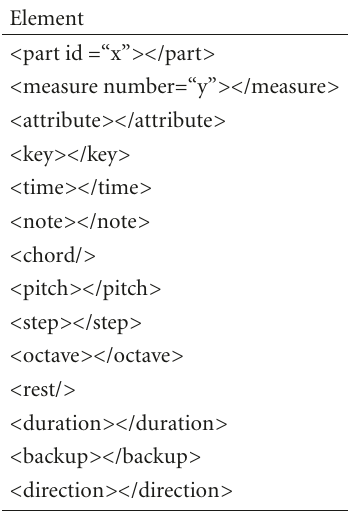
Figure 4: A sample tree structure of elements with the MusicXML format. Table 4: Frequently used